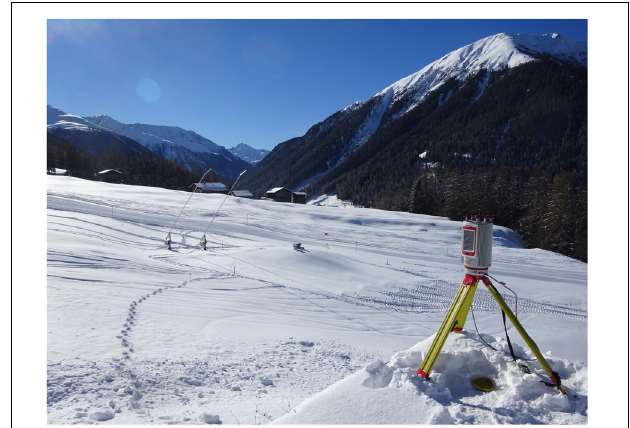
FIGURE 2 | Study site at the Rinerhorn after snow-making experiment, seen from northeast. The Riegl VZ6000 is visible in the